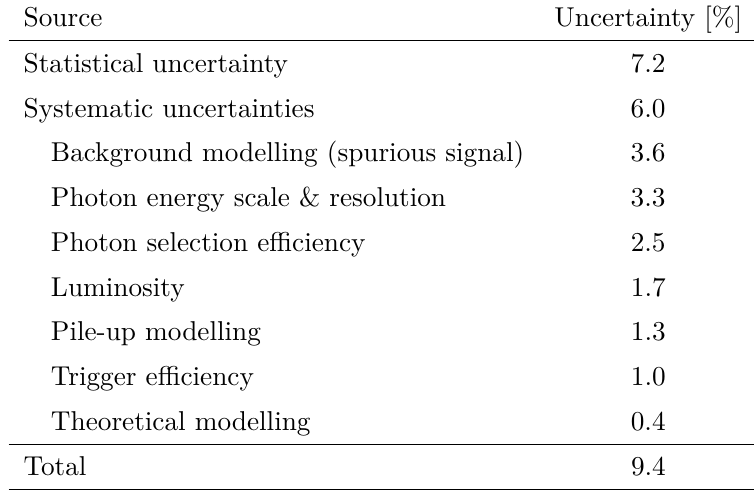
Table 4. Breakdown of the uncertainties in the inclusive diphoton fiducial cross-section measurement.